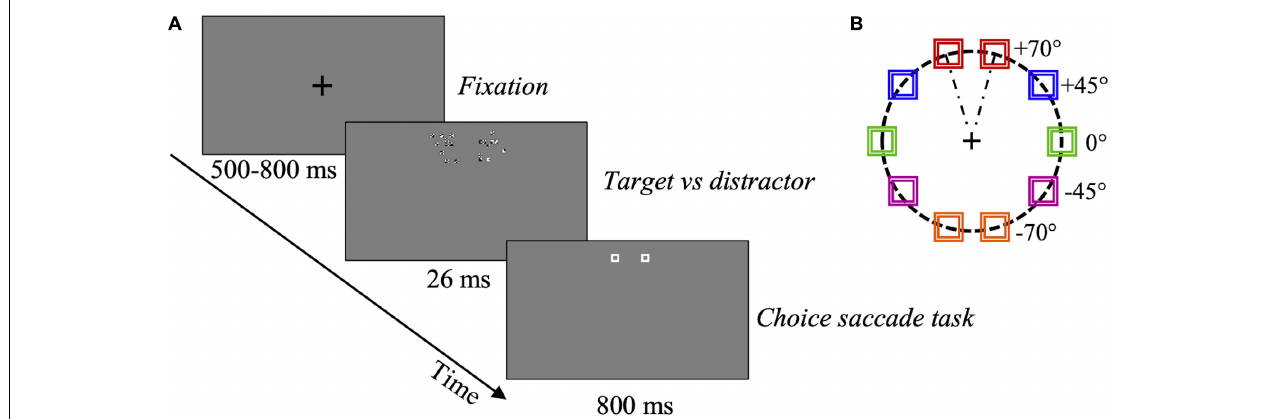
FIGURE 3 | Eye movements experiment procedure. (A) Schematic representation of one trial. After a random-duration fixation period, one compound comprising a variable proportion (SNR) of optimal features (target), and a compound with non-optimal features (distractor), were presented to the right or left, at different angles, for 26 ms. Then, two placeholders were shown at the target and distractor locations for 800 ms. In this example, target SNR = 60%. For an enlargement showing the configuration of the actual compounds see Figure 2C . (B) Target and distractor compounds could be presented randomly at one of 5 different locations (0 ◦ , ± 45 ◦ , ± 70 ◦ ) as defined in the text, illustrated by different colors, at 5 deg eccentricity. Red: angle + 70 ◦ ; blue: angle + 45 ◦ ; green: angle 0 ◦ ; violet: angle –45 ◦ ; orange: angle –70 ◦ .